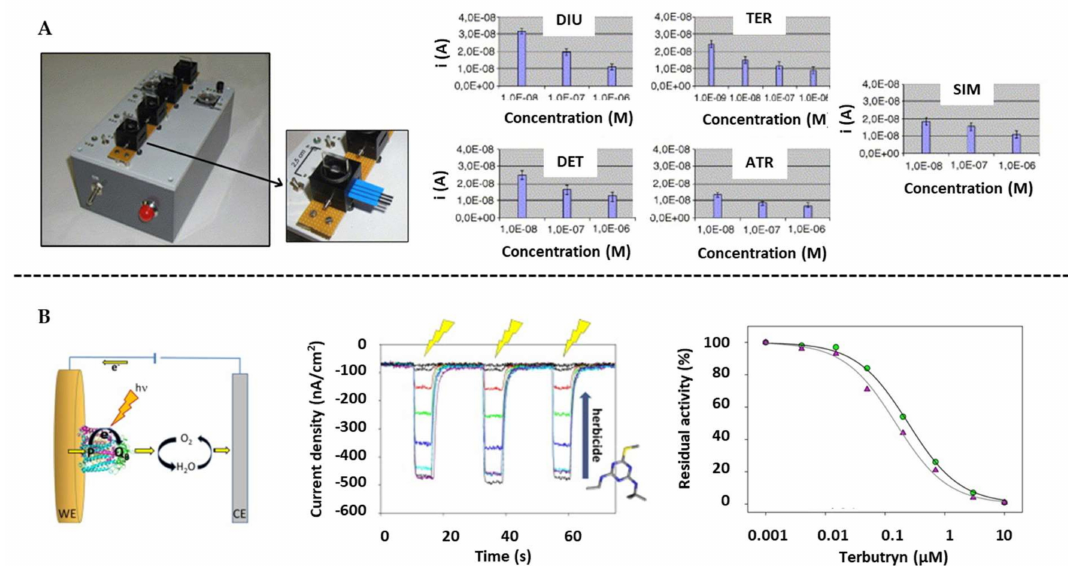
Figure 8. Biological sensors for pesticides determination on screen-printed electrodes: ( A ) Multi-flow detector device for the determination of herbicides using PS II as oxidoreductase. Representation of the current decrease with the herbicide’s concentrations. Reprinted from [199], Copyright 2005, with permission from Elsevier. ( B ) Scheme of a biosensor using bacterial reaction centers on gold SPE for the determination of Terbutryn. Photocurrents detected by LIFT and Terbutryn curves in absence and presence of 80 µ M of 2,3-dimethoxy-5-methyl-p-benzoquinone (UQ 0 ) (inset the Dixon plot). Reprinted from [200], Copyright 2016, with permission from